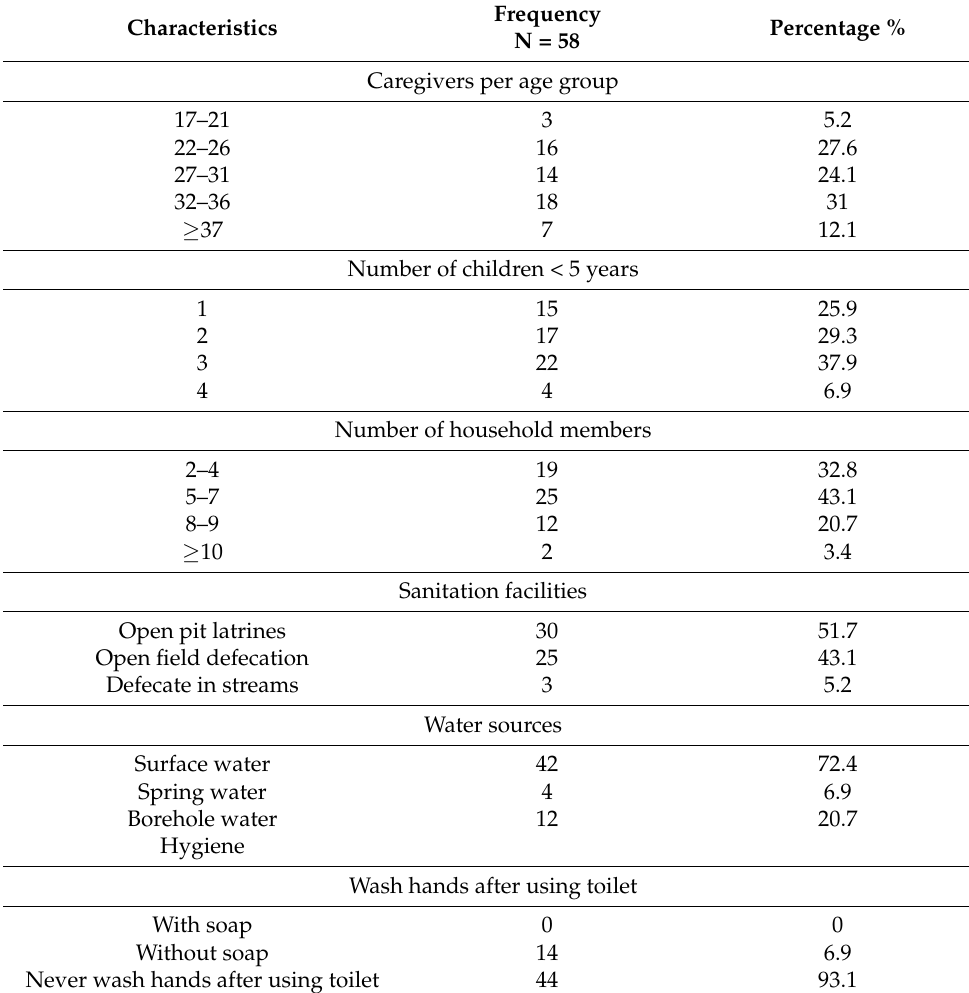
Table 2. Socio-demographic data of Makwane households surveyed subsequent to implementation of HWTS